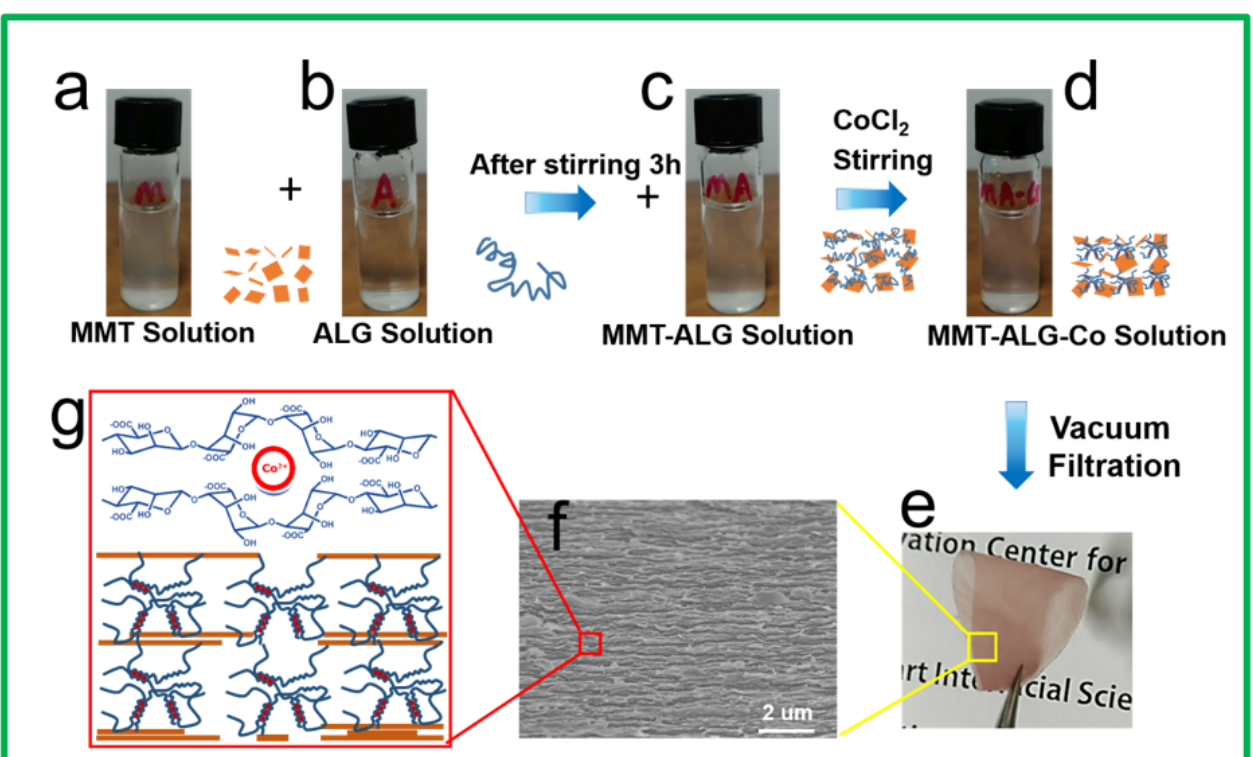
Figure 1. ( a – e ) show the MMT-ALG-Co 2+ composites preparation process; ( e ) The picture shows the pink nacre-like film is flexible and can be folded; ( f ) The SEM image of the cross-section of MMT-ALG-Co 2+ composite shows obvious layered arrangement structure; ( g ) Sketch map shows the Co 2+ crosslinking with the ALG.